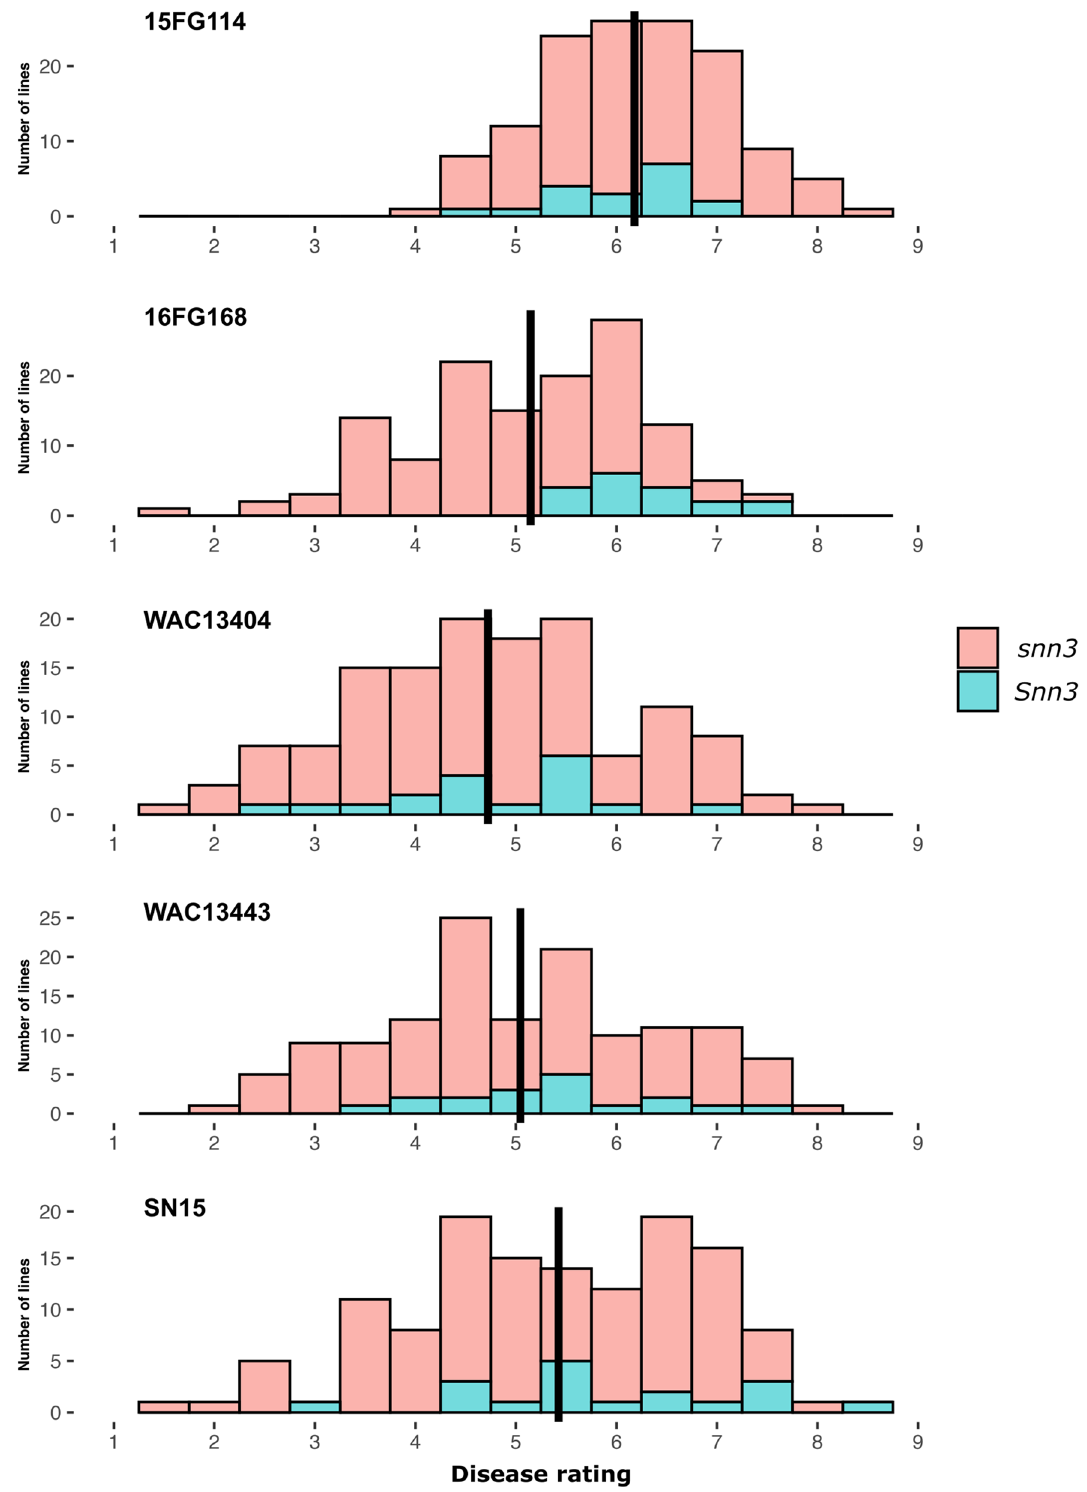
Figure 1. Histograms showing Septoria nodorum blotch ratings (1–9) of 134 wheat lines against five different isolates of Parastagonospora nodorum as noted on the top left of each graph. The vertical black bar indicates the mean of the disease rating from the respective isolate. Cyan colour indicates the proportion of lines carrying Snn3 . This Figure was produced using ggplot2 version 3.3.3 (2020-12-30) in R 43